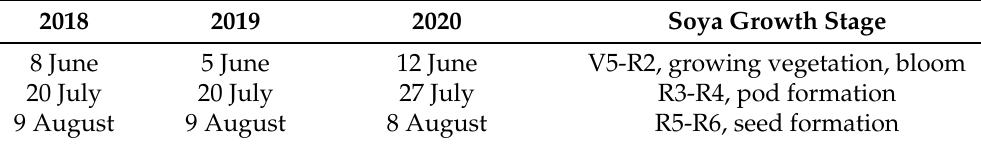
Table 2. Dates of Sentinel-2 image acquisition with the corresponding soya growth